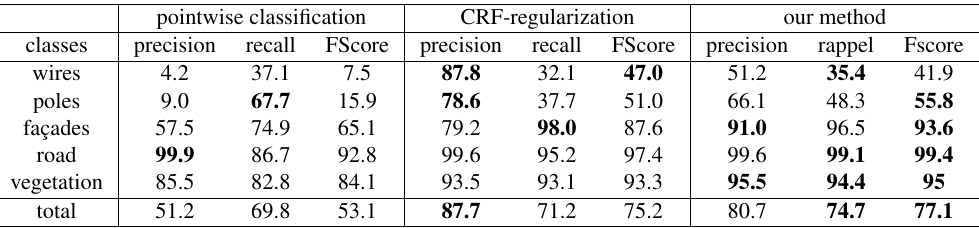
Table 1. Precision, recall and FScore in % for the Oakland benchmark. The global accuracy are respectively 85.2%, 94.8% et 97.3%. In bold, we represent the best value in each category.